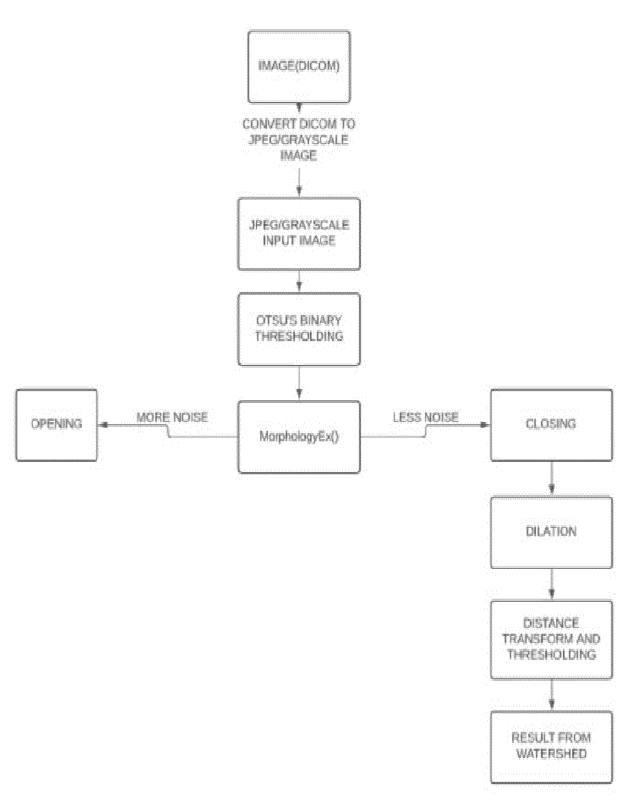
Figure 3.2: Otsu's Thresholding Flow